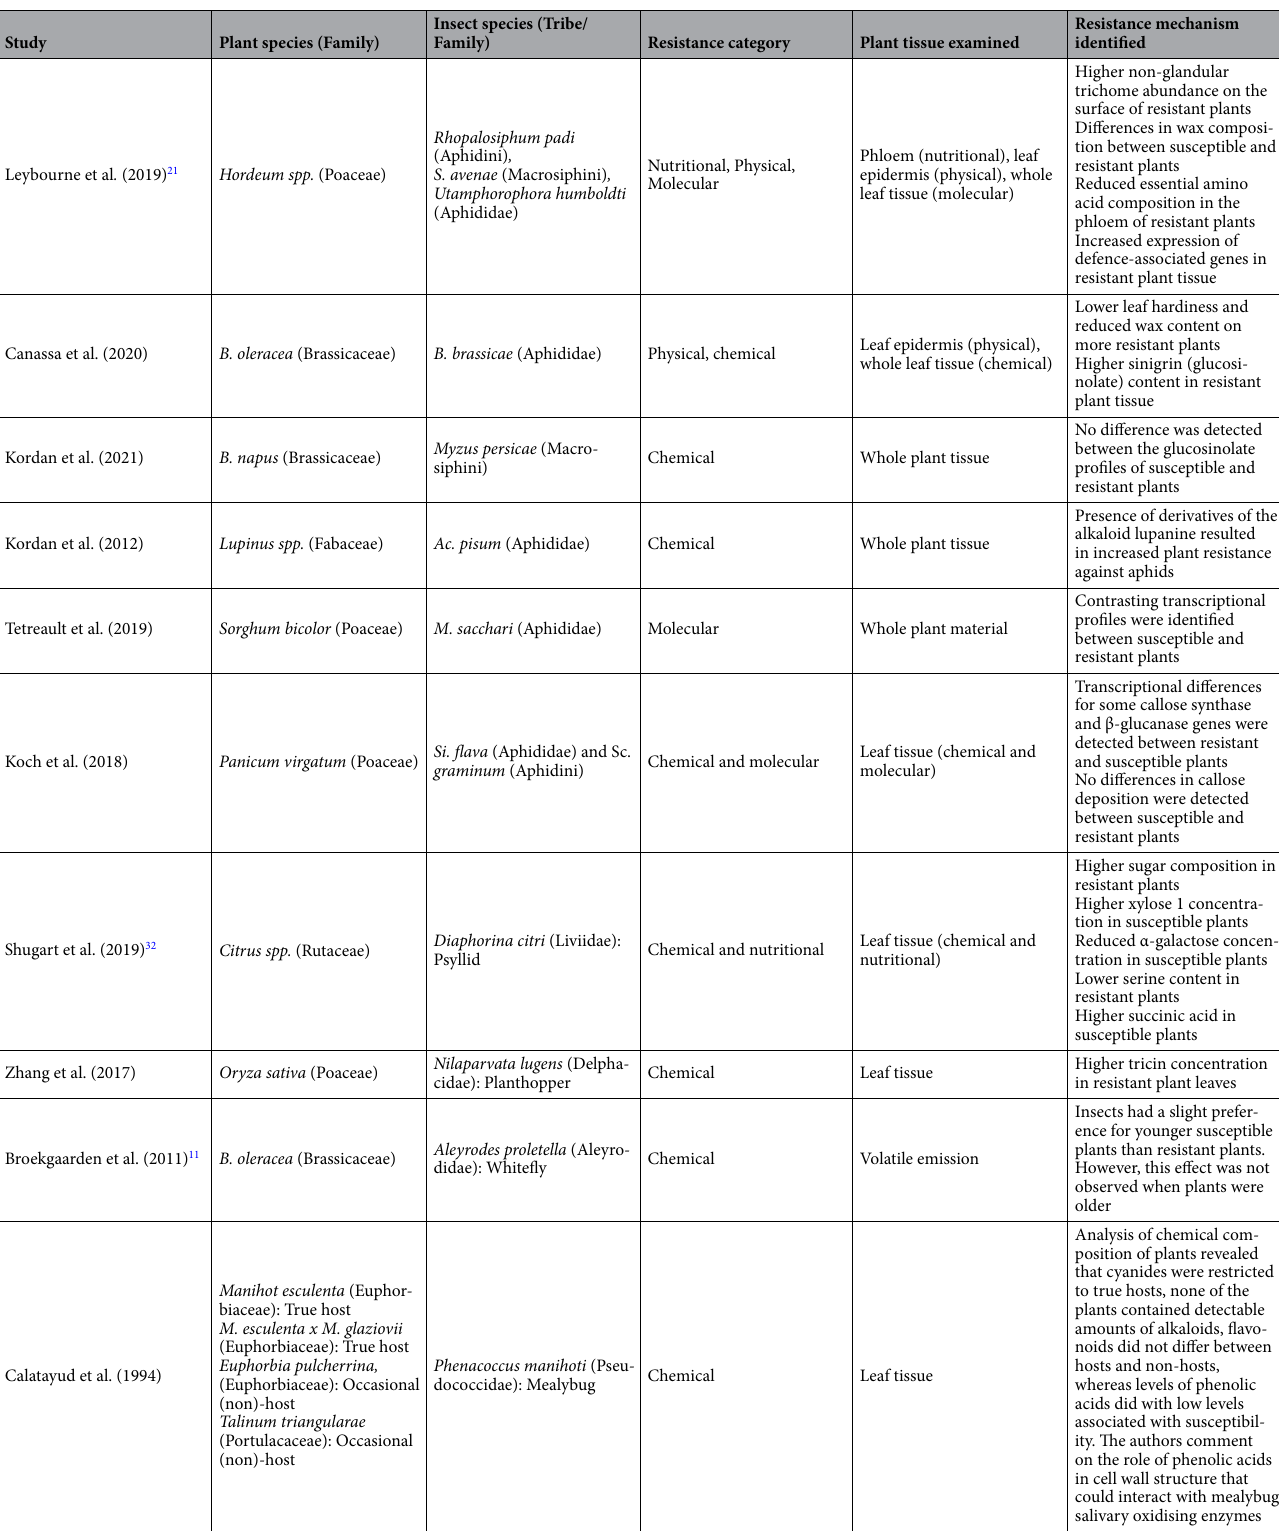
Table 1. Overview of the plant resistance mechanisms characterised in each study. Resistance mechanisms have been grouped into one of four resistance